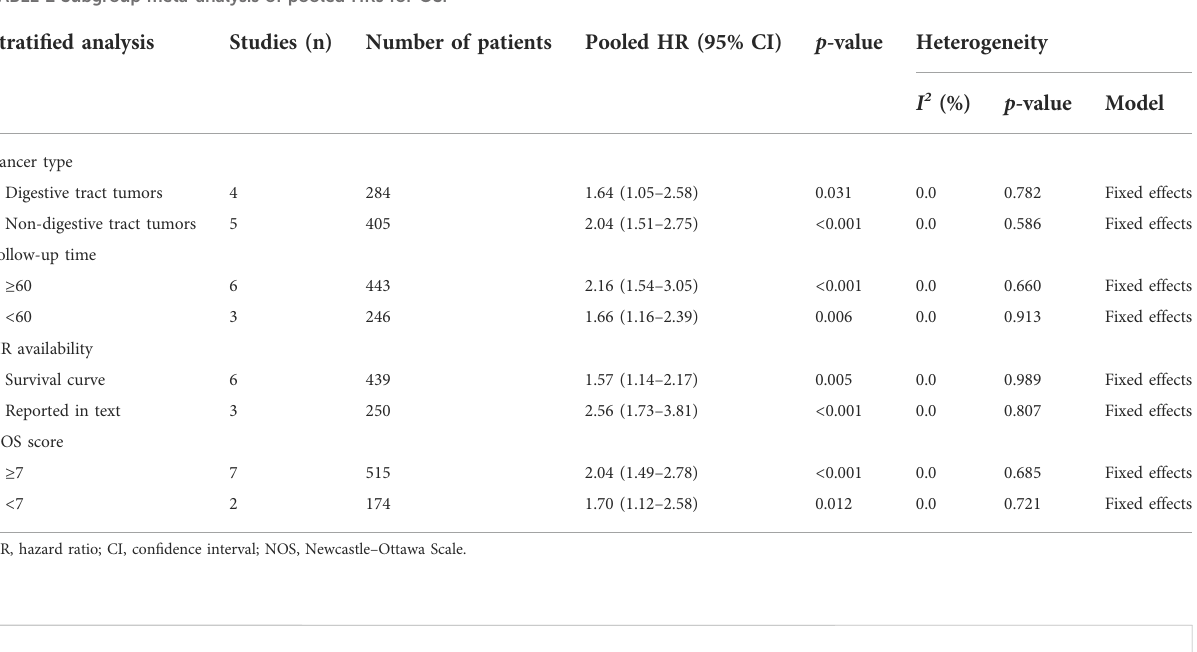
TABLE 2 Subgroup meta-analysis of pooled HRs for